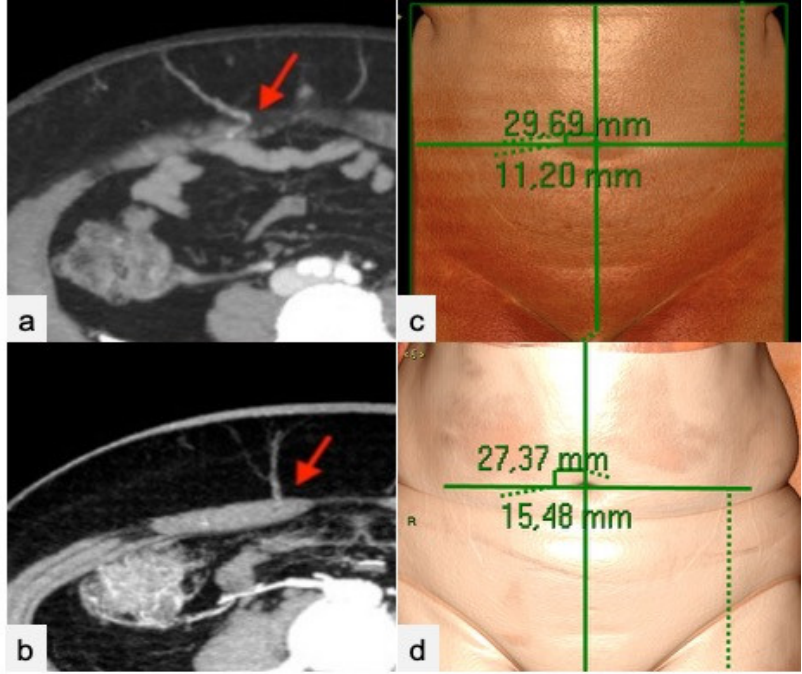
Figure 3. Dominant perforator’s emergence from the anterior rectus abdominis fascia (red arrows) in cCT ( a ) and CTa ( b ) axial sub-volume maximum intensity projection (MIP) reconstructions. Images ( c , d ) show mapping of the dominant perforator on a VR reconstruction of the abdominal surface via a virtual coordinate system centered on a zero point, corresponding to the umbilicus in cCT ( c ) and CTa ( d ).